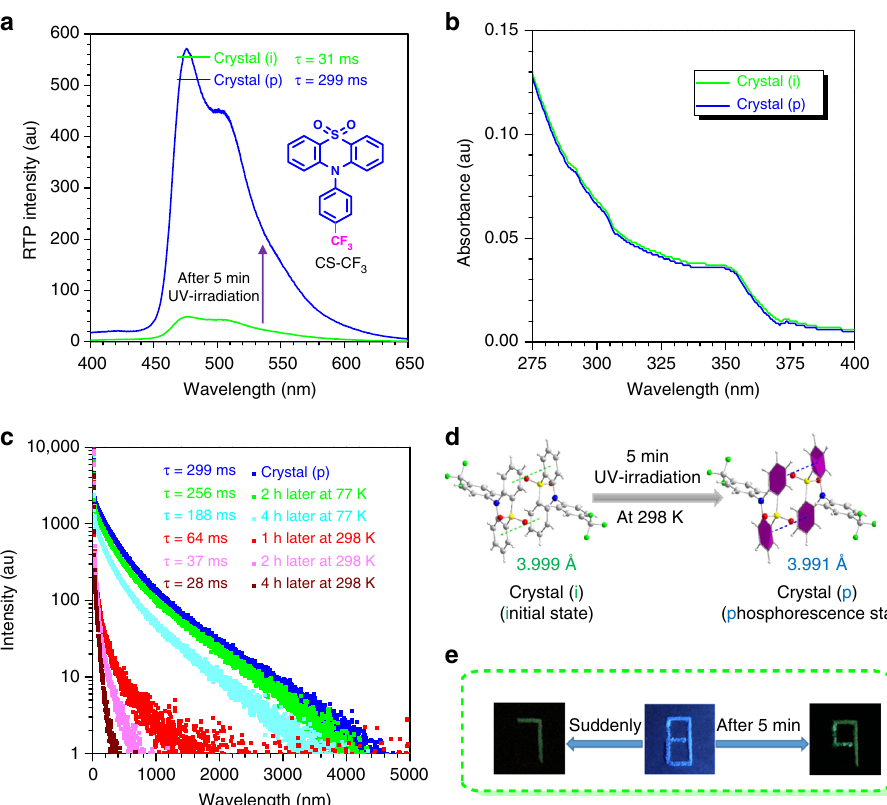
Fig. 5 The photo-induced phosphorescence property of CS-CF 3 . a The room temperature phosphorescence spectra of CS-CF 3 crystal before and after 365 nm UV irradiation for 3 min. b The UV – visible spectra of the CS-CF 3 crystal before and after UV irradiation for 5 min. c Time-resolved PL-decay curves for the room temperature phosphorescence of CS-CF 3 crystal under 5 min 365 nm UV irradiation and after 1 or 2 or 4 h of standing at 77 K or 298 K. d The crystal structures of coupled CS-CF 3 before and after UV irradiation for 5 min. e Double security protection applications by using three kinds of components of CS-CF 3 , CS-F and (4-methoxyphenyl)(phenyl)methanone. Under 365 nm UV irradiation, it presents blue pattern 8; then switching off the UV light suddenly, it turns to green pattern 7; if the UV irradiation could be kept for about 5 min, it would appear green pattern 9 after turning off the